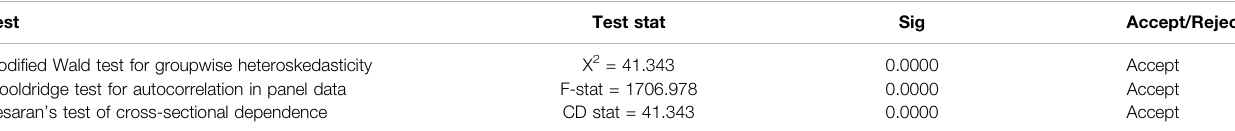
Figure 2 comprises of multiple regression graphs prepared by using ORIGIN software for two regressions considering the two independent variables separately. Insolvency risk is plotted at the y -axis. The graph on the left side considers the IFG as independent variable, whereas the graph on right considers EFG as independent variable. The other variables included are the mediator, the interaction term and the control variables in both the graphs. It is abvious from this fi gure that on the whole the panel data series are near to the best line of fi t with few distortions in the shape of spikes above and below the regression line. It depicts the presence of heterogeneity in data values. This fi gure also con fi rms the suitability of a regression model that better tackles the